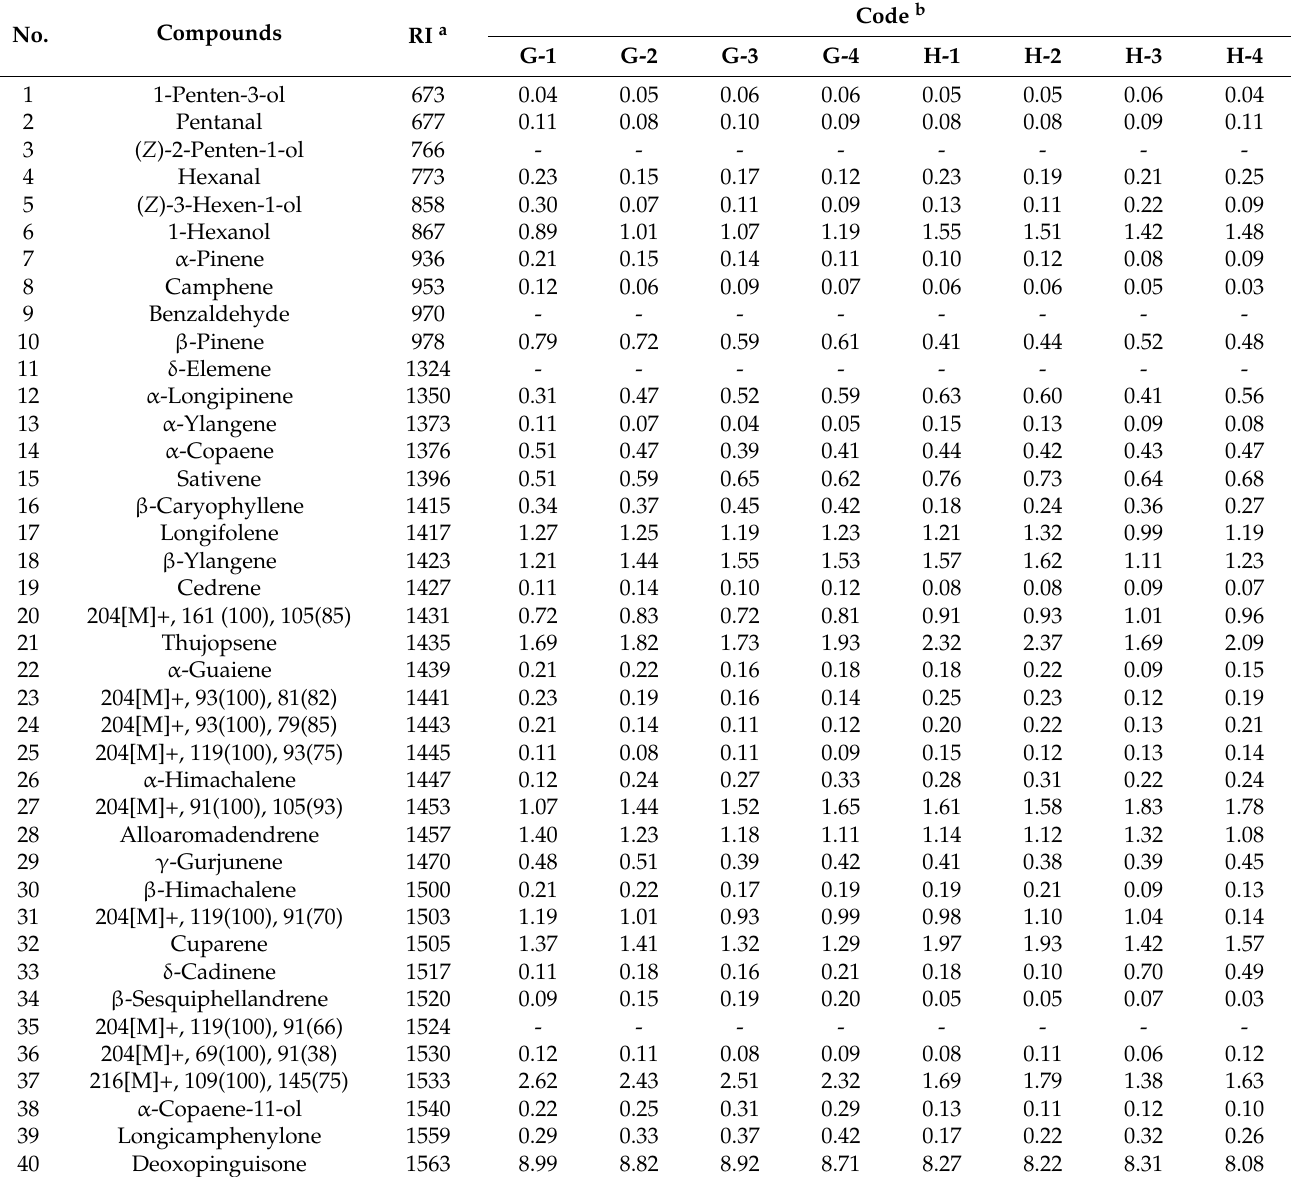
Table 5. Volatile compounds detected in the analyzed samples of cryptic species G and H of the A. pinguis.